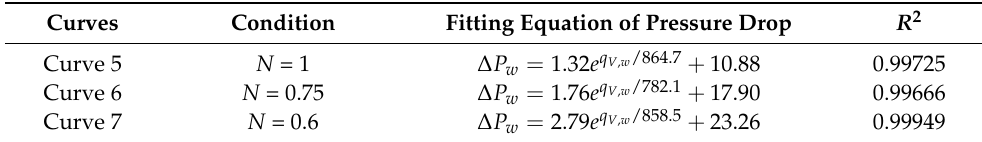
Figure 14. Flow characteristics under different q V , w : ( a ) Pressure drop; ( b ) Power consumption of pumps. Table 7. Fitting curves of pressure drop of water side at different N.